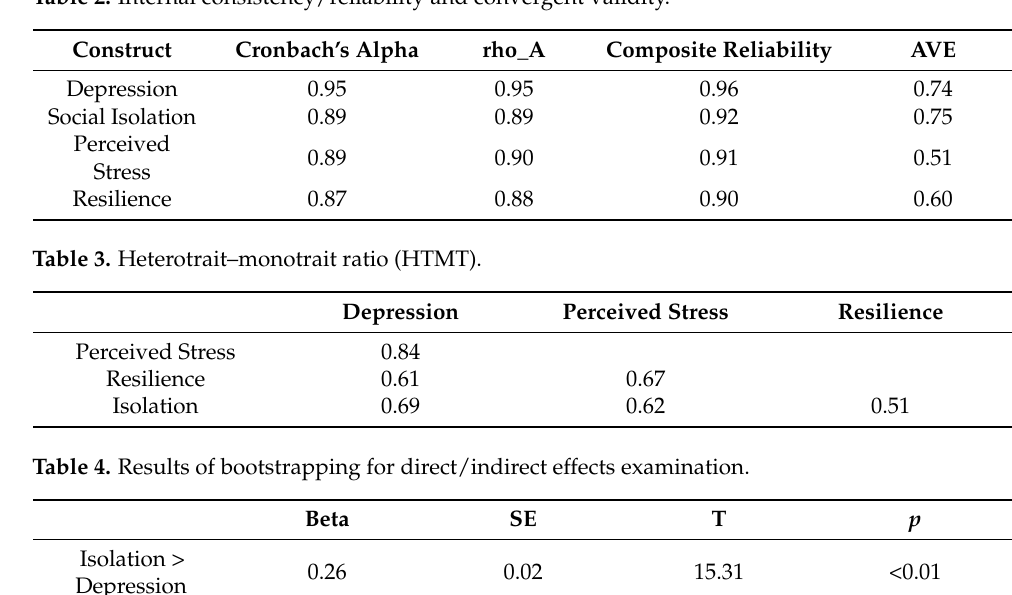
Figure 1. Conceptual model and PLS-SEM results. Table 2. Internal consistency/reliability and convergent validity.